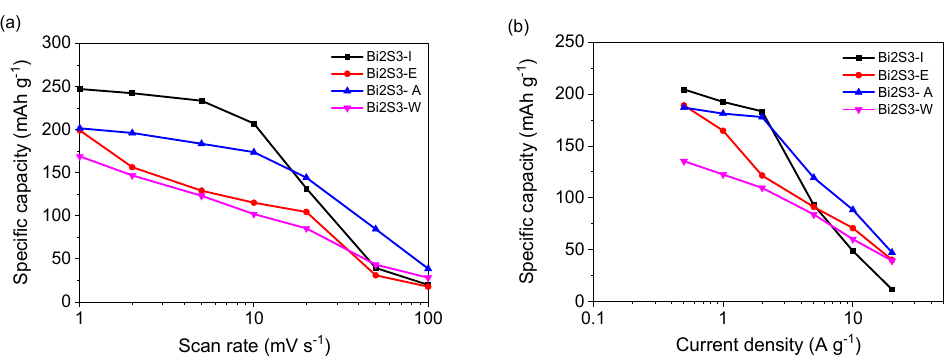
Figure 7. Specific capacity versus scan rate ( a ) and discharge current density ( b ) of the bismuth sulfides.